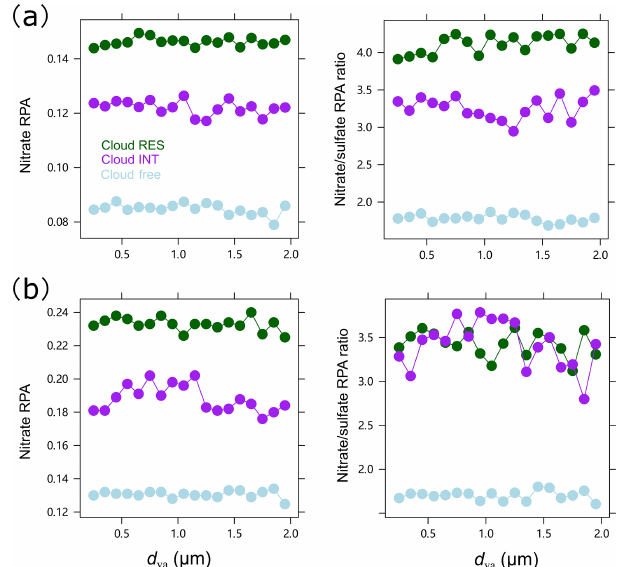
Figure 2. Size-dependent RPA of nitrate and RPA ratio of ni- trate/sulfate, separated for all the detected cloud-free, cloud resid- ual (RES), and cloud interstitial (INT) particles, in (a) spring 2018 (May) and (b) winter 2020 (November–December),